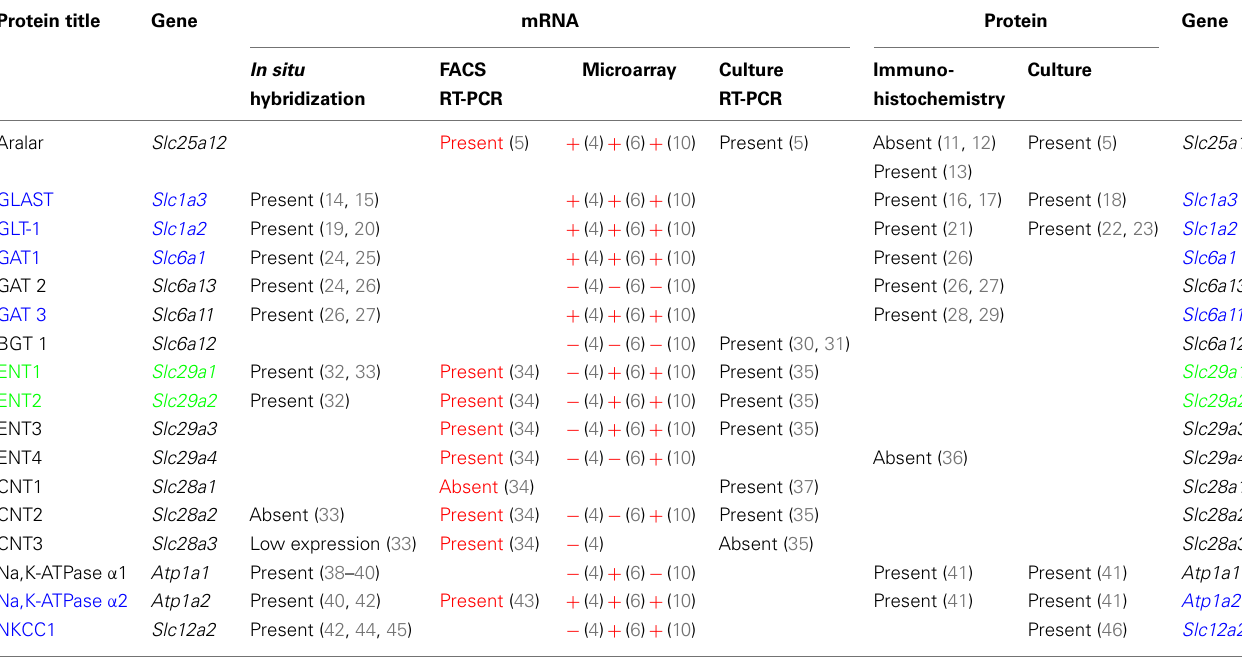
Table 1 | Expression of astrocytic genes determined by different methodologies